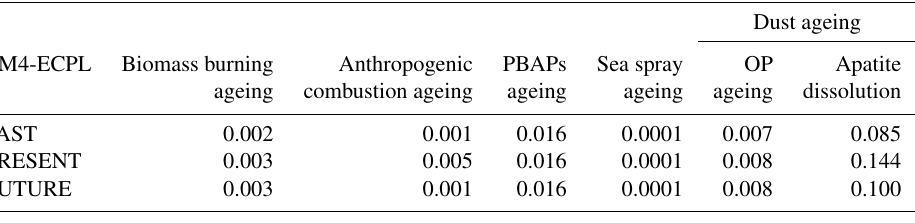
Table 3. Secondary DP sources (in Tg-Pyr − 1 ) due to OP ageing contained in biomass burning, anthropogenic combustion, sea spray and dust as well as due to dust (apatite) dissolution via the acid-solubilization mechanism, as calculated by the TM4-ECPL model for PAST, PRESENT and FUTURE simulations.